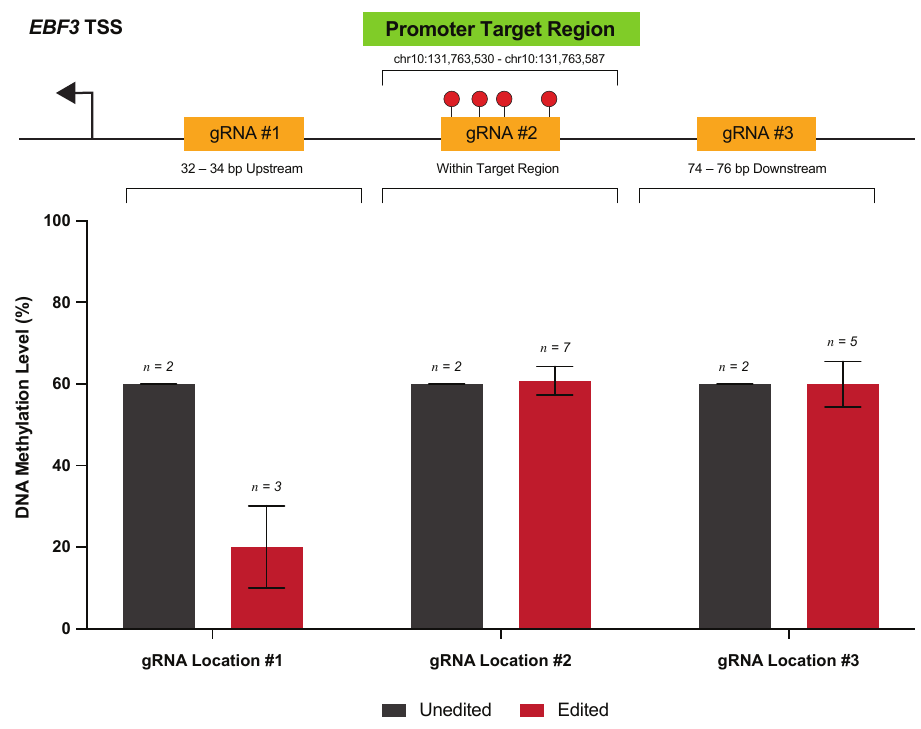
Figure 2. Variable efficacy of gRNAs designed to target the EBF3 promoter. Shown are the three loca- tions of the EBF3 promoter, for which gRNAs were designed via in silico selection. For each location, two gRNA were designed, targeting the sense and antisense strands, respectively. Methylation levels within our target 58 bp locus are reported for cell line NZM40 in unedited versus edited samples for each of the gRNA locations targeted. The position of each gRNA location with respect to the target locus is also